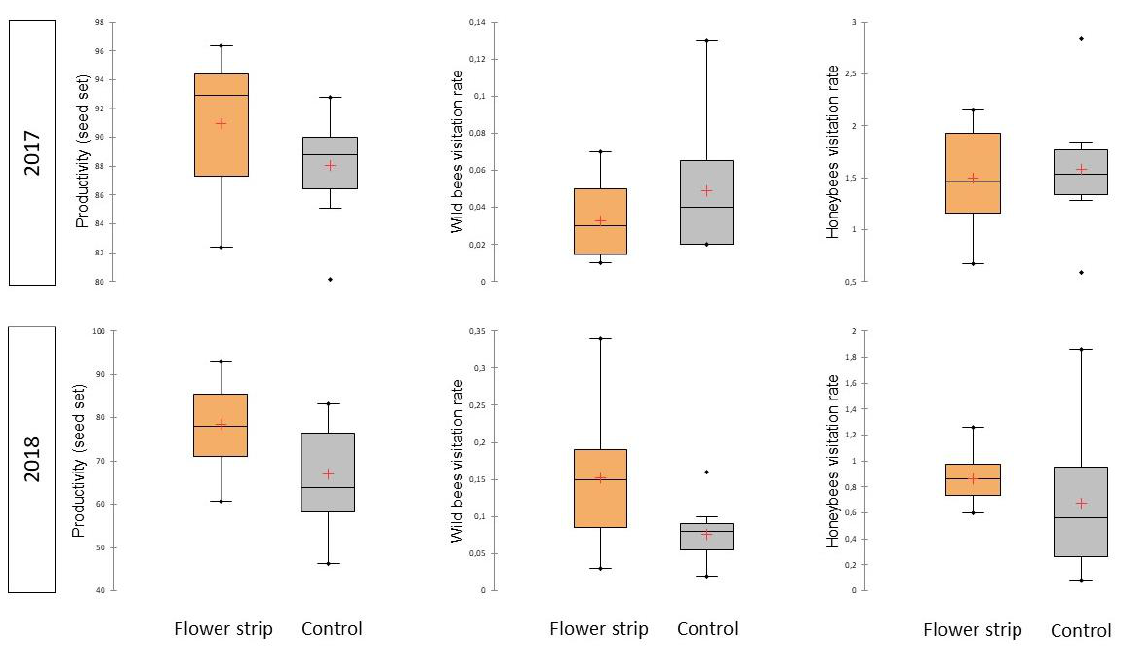
Figure 3. Box-plots showing the differences between fields with the installed flower strips and control fields regarding the productivity-seed set ( left ), wild bee visitation rate ( middle ), and honeybee visitation rate ( right ).